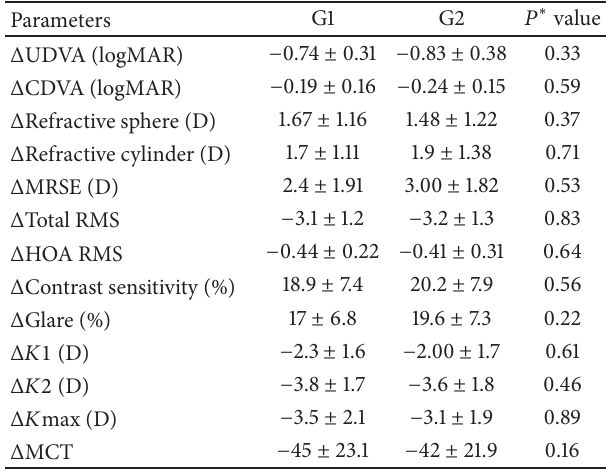
Table 6: Comparison of changes over 12-month period in visual, refractive, aberrometric, and topographical parameters between the 2 studied groups.